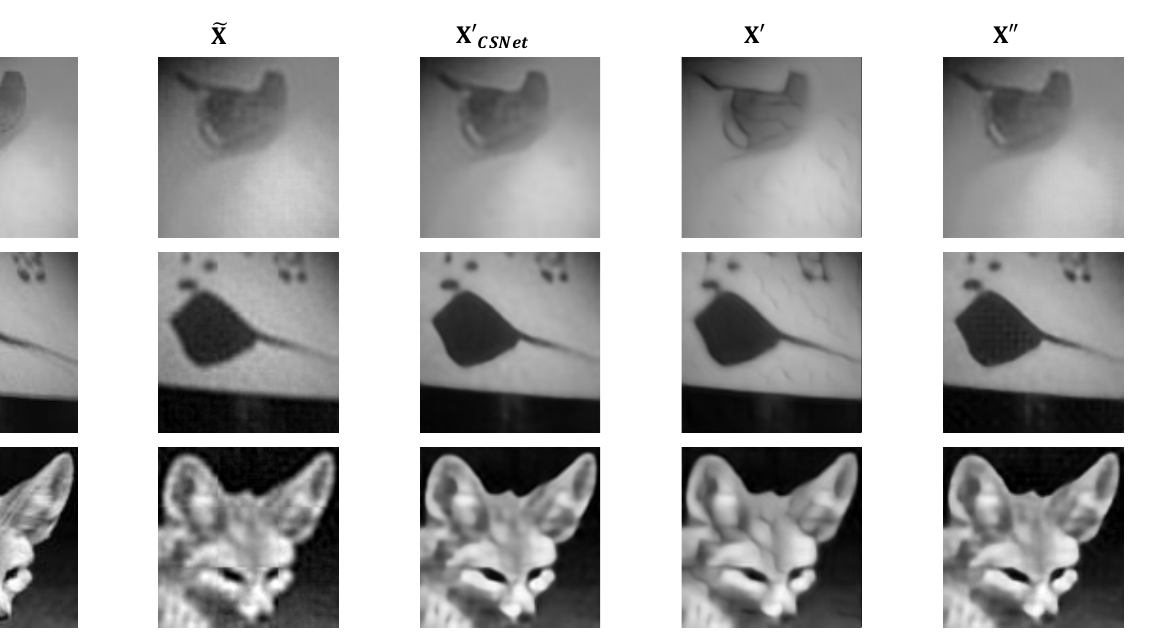
(cid:48) and X (cid:48)(cid:48) CSNet , X